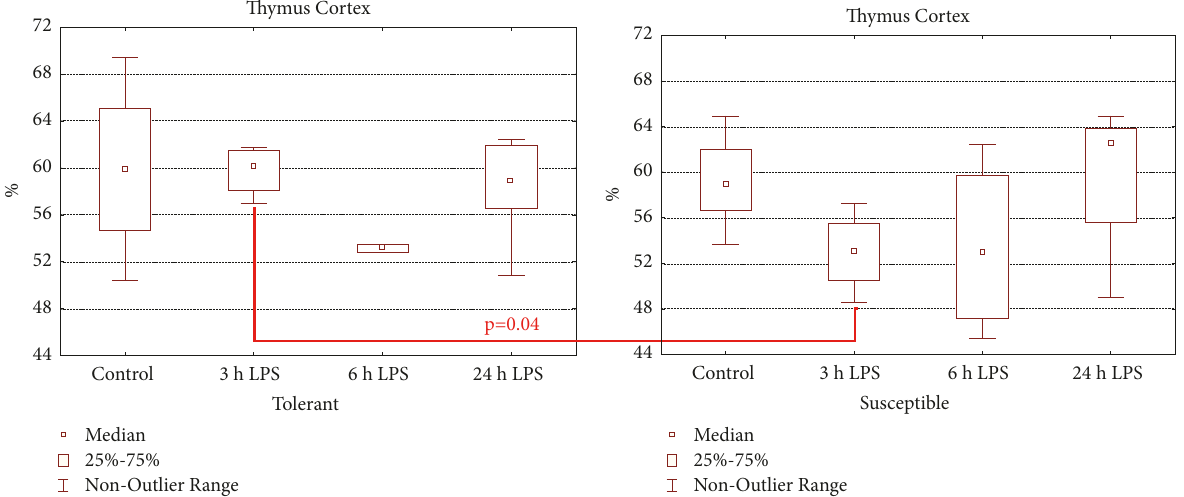
Figure 4: The volume fractionof the thymus cortexin tolerant-and susceptible-to-hypoxiaratsafter 3, 6, and 24 hours of LPS administration. Data are presented as median (25%, 75%); the statistical significance of differences ( p ) between tolerant and susceptible rats is determined by the Mann-Whitney U test and between different time points after LPS injection by the Kruskal-Wallis method ( 𝑛 = 5 in each group).